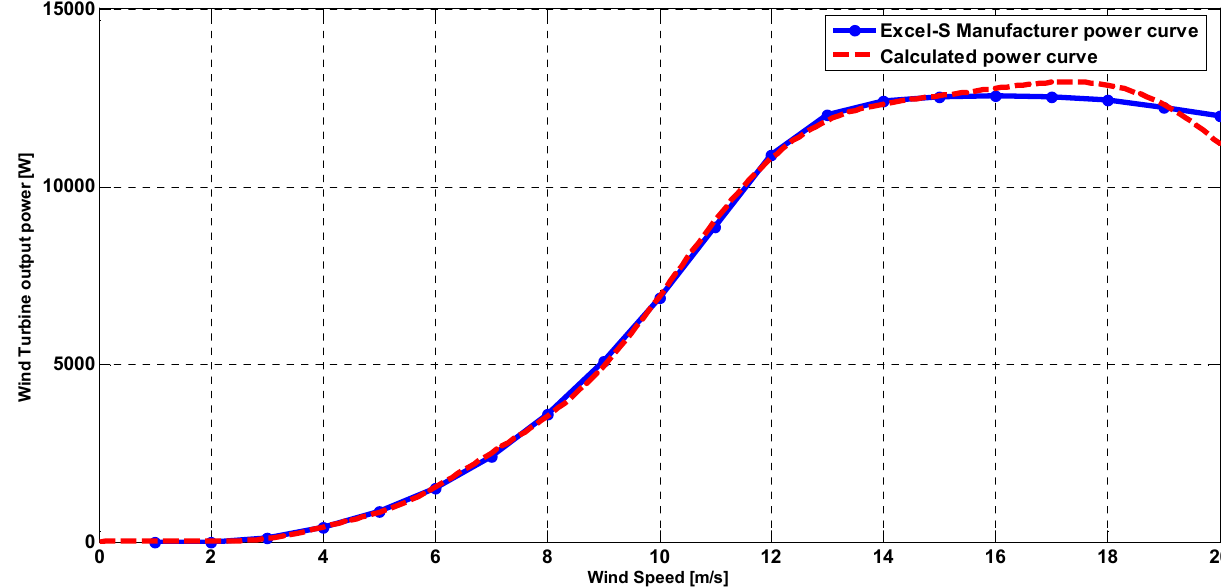
Figure 4. The calculated power curve V.S the manufacturer